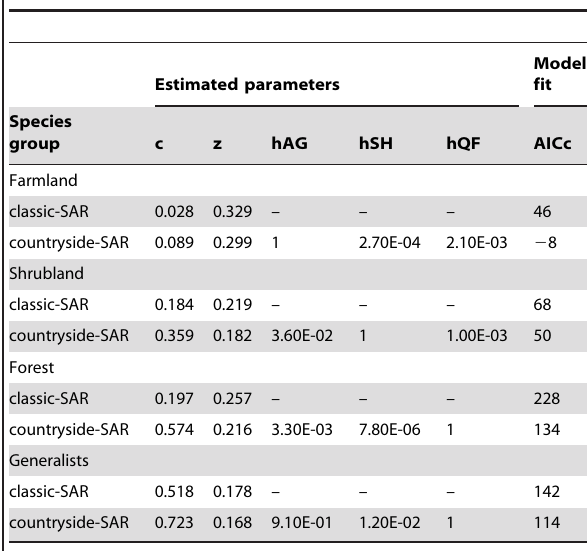
Table 3. Classic and countryside species-area relationships in the multi-habitat context of each species affinity group in the multi-habitat landscape.